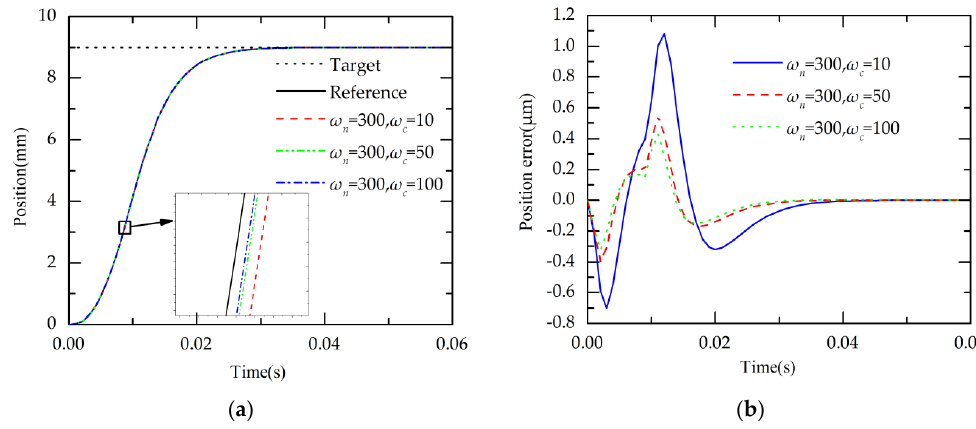
ω , when the ω , when the c c